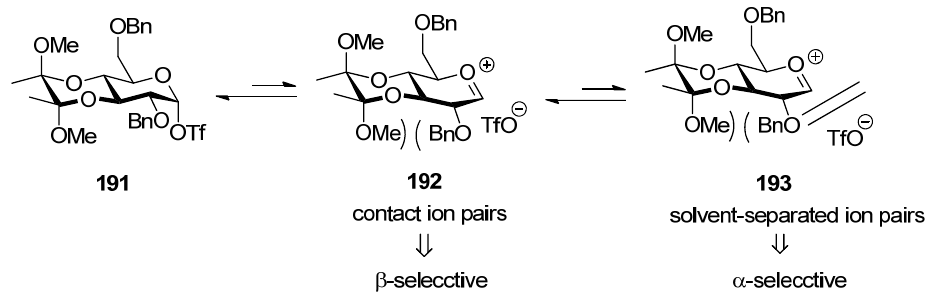
Figure 8. The influence of the 3,4-O-bisacetal group on glycosylation